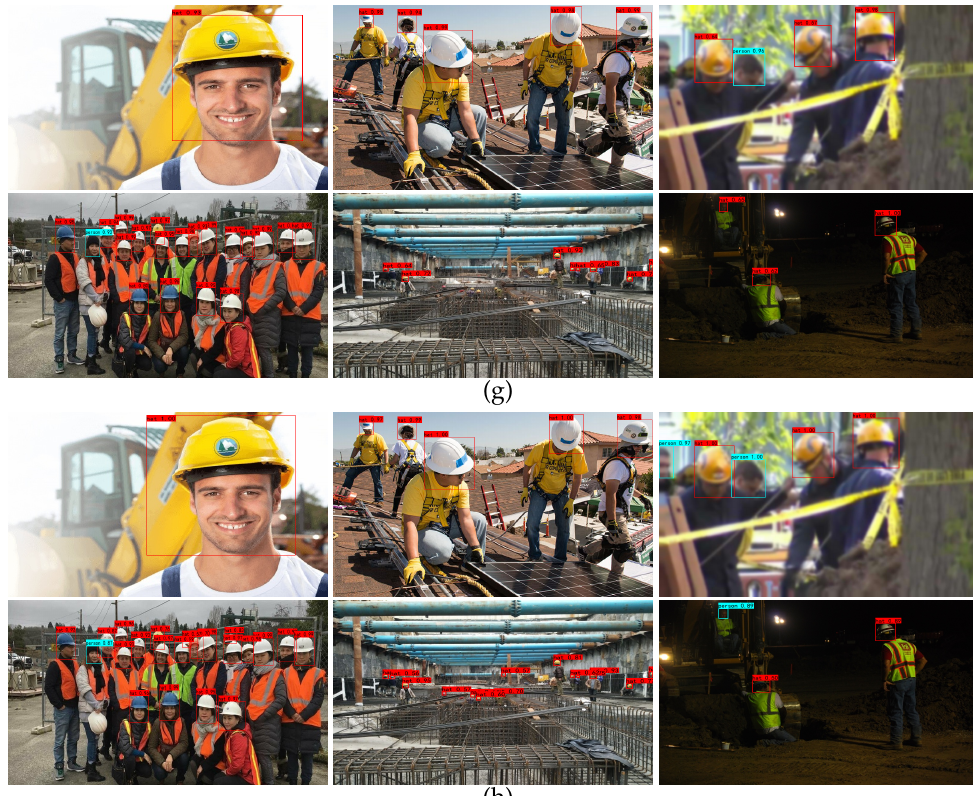
Figure 11. Comparison results of actual detection with different algorithms: ( a ) Faster R-CNN; ( b ) CenterNet; ( c ) SSD; ( d ) EfficientDet-D2; ( e ) Ghost-YOLOv4; ( f ) YOLOv4-Tiny; ( g ) YOLOv4; and ( h ) Improved YOLOv4. The images in the first row of each algorithm show the detection results for a single target, a small number of targets and blurred targets, respectively, while the images in the second row of each algorithm show the detection results for densely obscured targets, small targets at a long distance and poorly light targets,